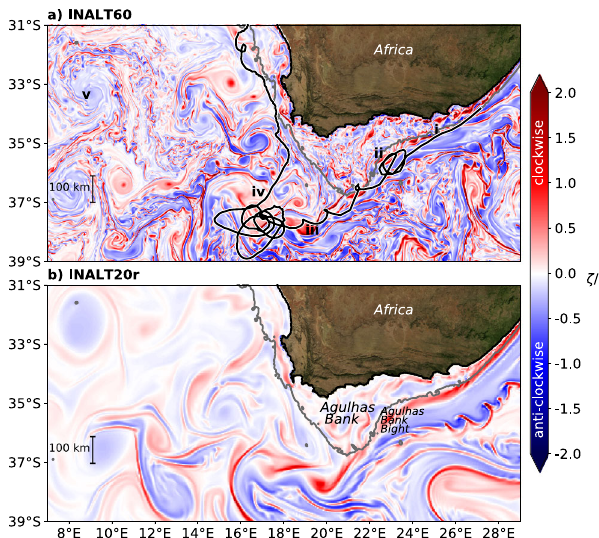
Fig. 1 Submesoscale fl ows in the Agulhas region. A zoom into snapshots of surface normalised relative vorticity (a measure of rotation) from INALT60 ( a ) and INALT20r ( b ) on model day July 18th 2012. The black- white line shows the trajectory of the Global Drifter Programme drifter number 101938 released on Feb 19th 2013. The extent of the Agulhas bank is highlighted with the 300 m isobath. Different dynamical features are marked: (i) submesoscale instabilities at the northern edge of the Agulhas Current (ii) a shear-edge cyclone in the Agulhas Bank Bight, (iii) a shear- edge cyclone southwest of the Agulhas Bank, (iv) a lee cyclone, and (v) an Agulhas ring with surrounding submesoscale vortices. For land areas a satellite picture is shown 49